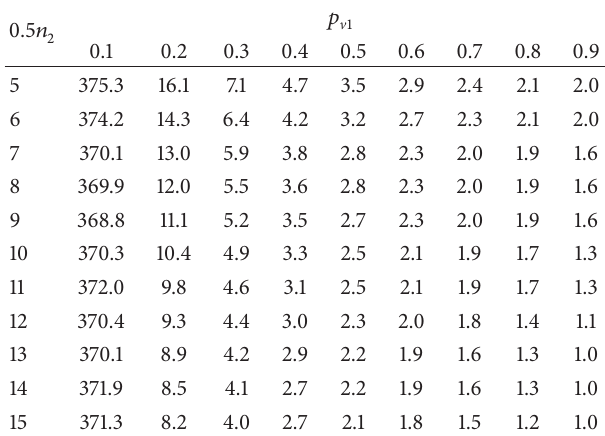
Table 7: The ARL V 1 of the EWMA-AV chart for 𝜆 2 = 0.05 and 𝑝 V 0 = 0.1 .